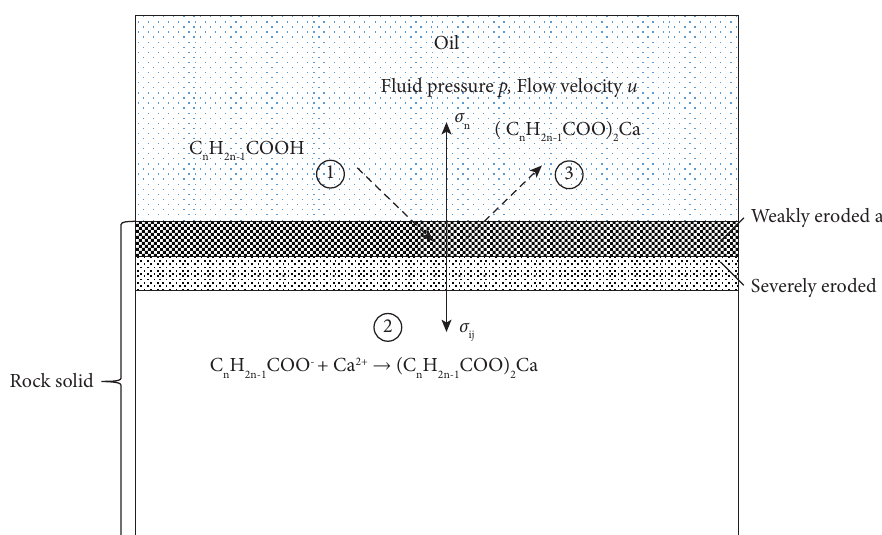
Figure 13: Deterioration process of interlayer under oil-mudstone